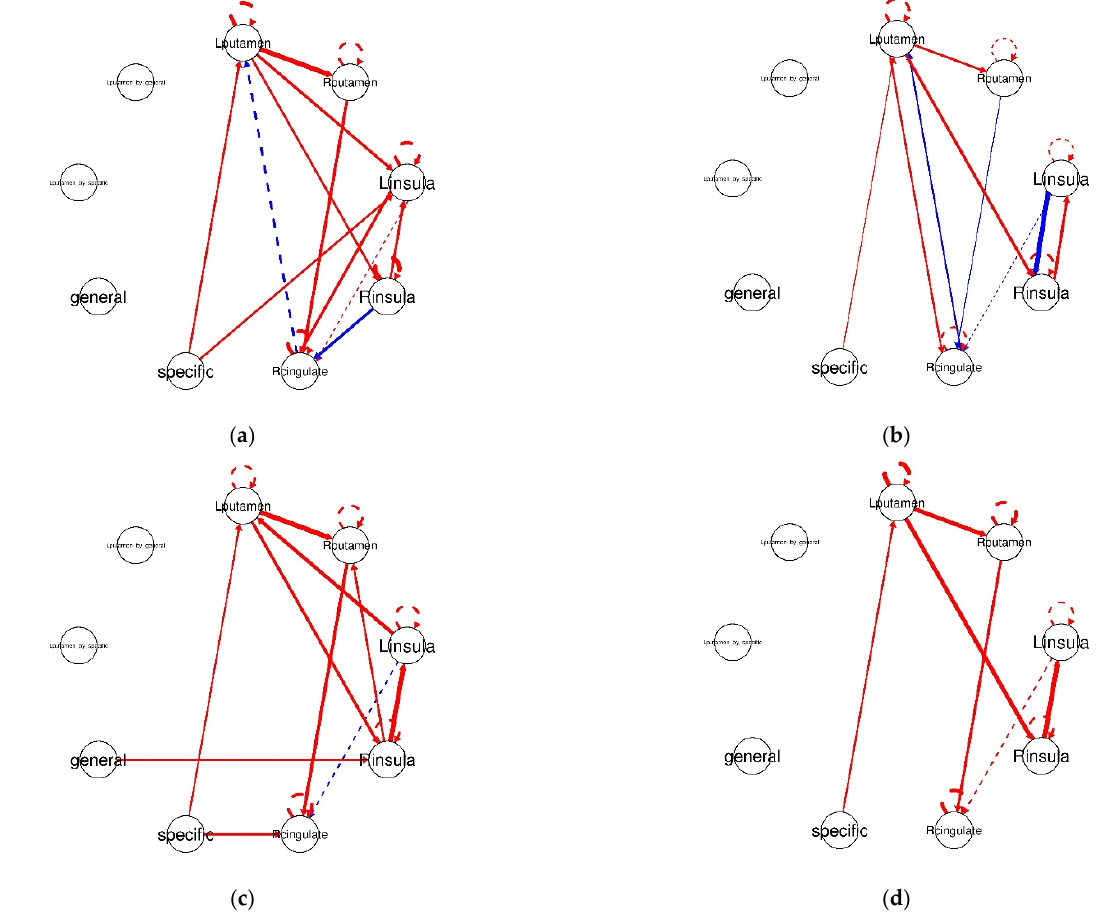
Figure 5. Effective connectivity plots recovered by HRF-GIMME for four participants. Red lines indicate a positive connection, blue lines indicate a negative connection, solid lines indicate contemporaneous connections, and dashed lines indicate a lagged connection of the first order. The thickness of the lines indicates the magnitude of the connection, such that thicker lines indicate a stronger magnitude of connectivity. Note that variables specific, and general indicates the direct effects of the task on the other ROIs. In other words, the degree to which a task influences variability in BOLD activity at the corresponding ROI. ( a ) Participant 1 ′ s effective connectivity plot. ( b ) Participant 4 ′ s effective connectivity plot. ( c ) Participant 5 ′ s effective connectivity plot. ( d ) Participant 9 ′ s effective connectivity plot.